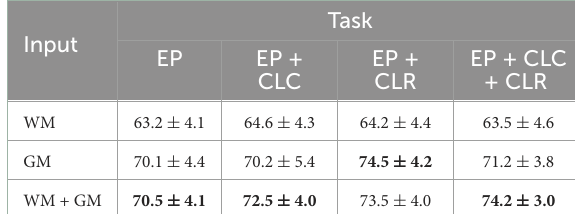
TABLE 3 Results of F 1 -score (%) for EP